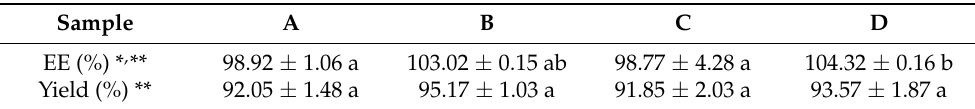
Table 3. Encapsulation efficiency of prepared solid lipid microparticles loaded with gentian extract